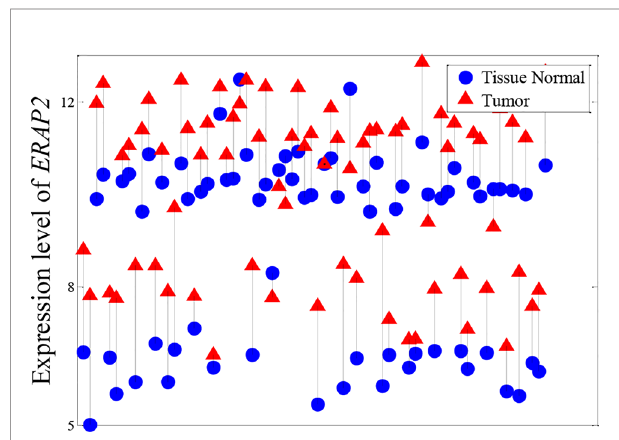
FIGURE 5 | Expression pattern of ERAP2 in KIRC. Tumor samples and paracarcinoma tissue samples from the same patient are connected by a black line.